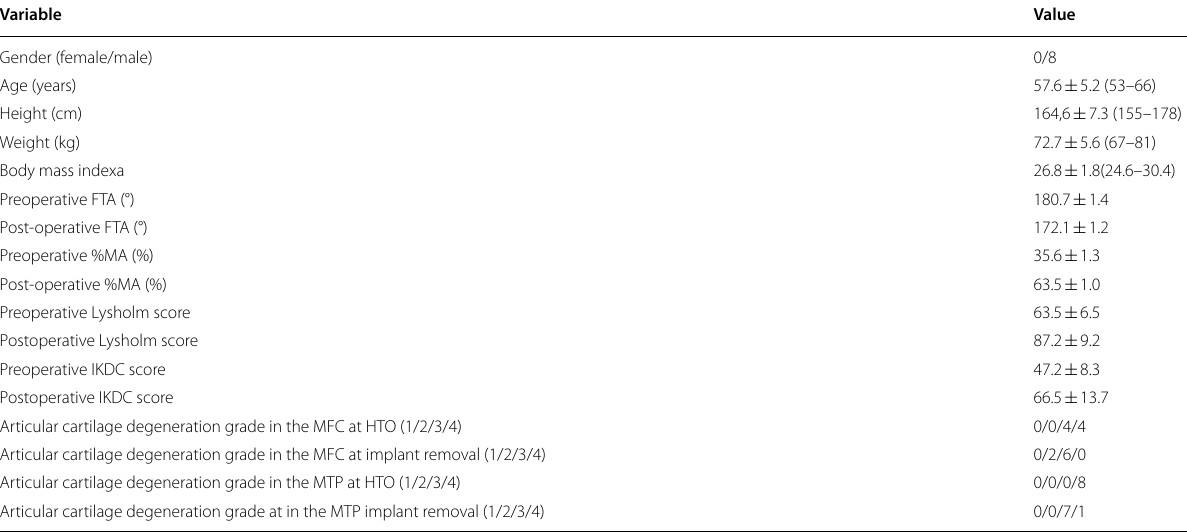
Articular cartilage degeneration grade was classified according to the arthroscopic grading system of the International Cartilage Repair Society FTA femorotibial angle, %MA percentage of mechanical axis, HTO high tibial osteotomy, MFC medial femoral condyle, MTP medial tibial plateau Values are expressed as mean standard deviation, with range in ±